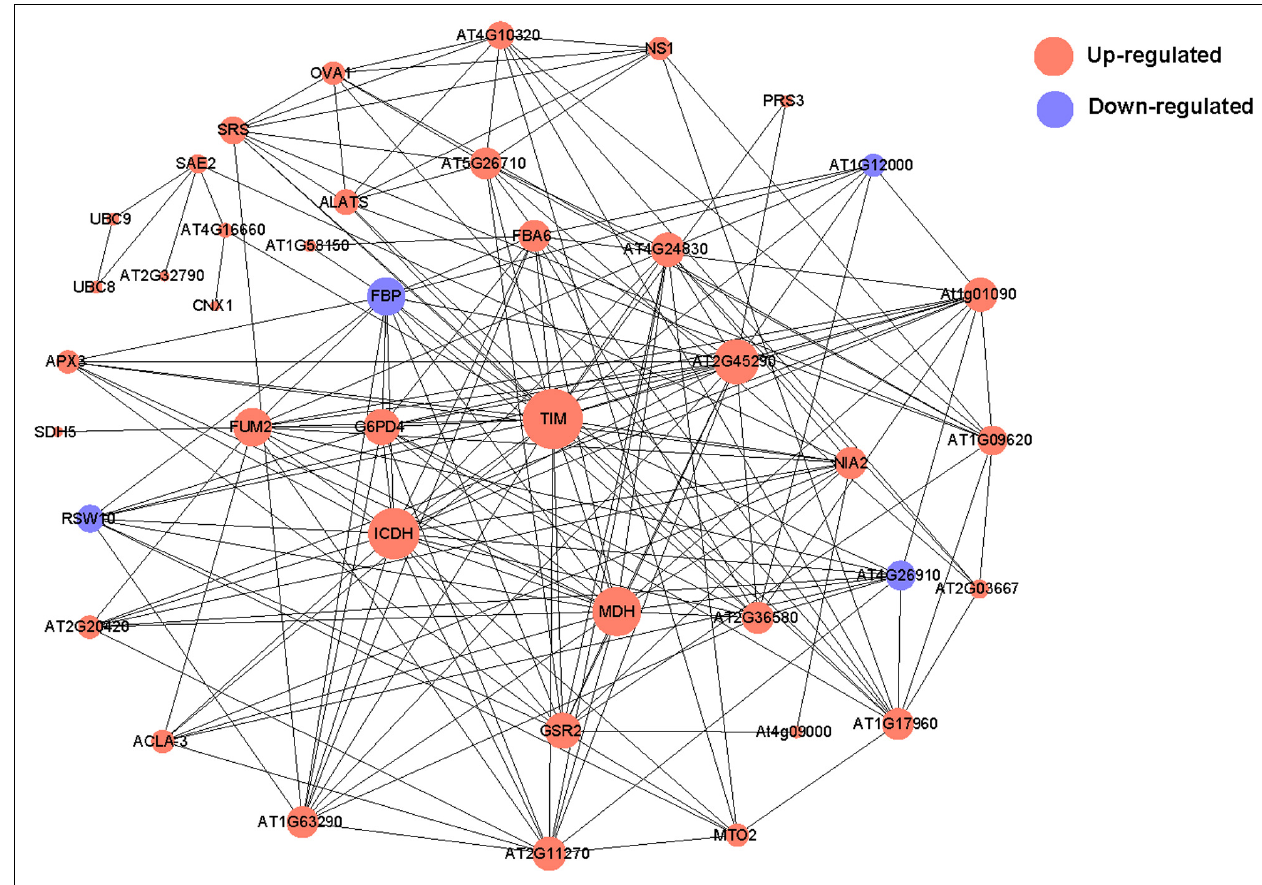
FIGURE 5 | Protein–protein interaction network for P. haitanensis thalli exposed to hypersaline stress for 4 h based on STRING and Cytoscape analyses. Red and blue correspond to increased and decreased abundances, respectively. Circle size represents the number of protein interactions. Minimum required interaction score > 0.4. Protein annotations are listed in Supplementary Table S6